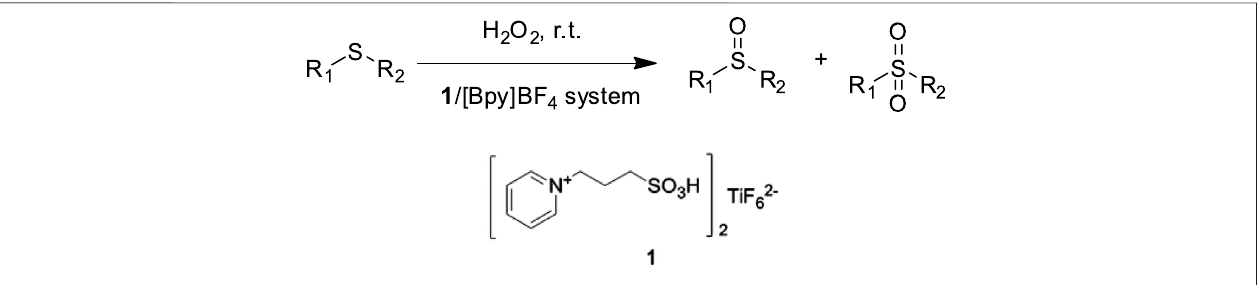
Frontiers in Chemistry |